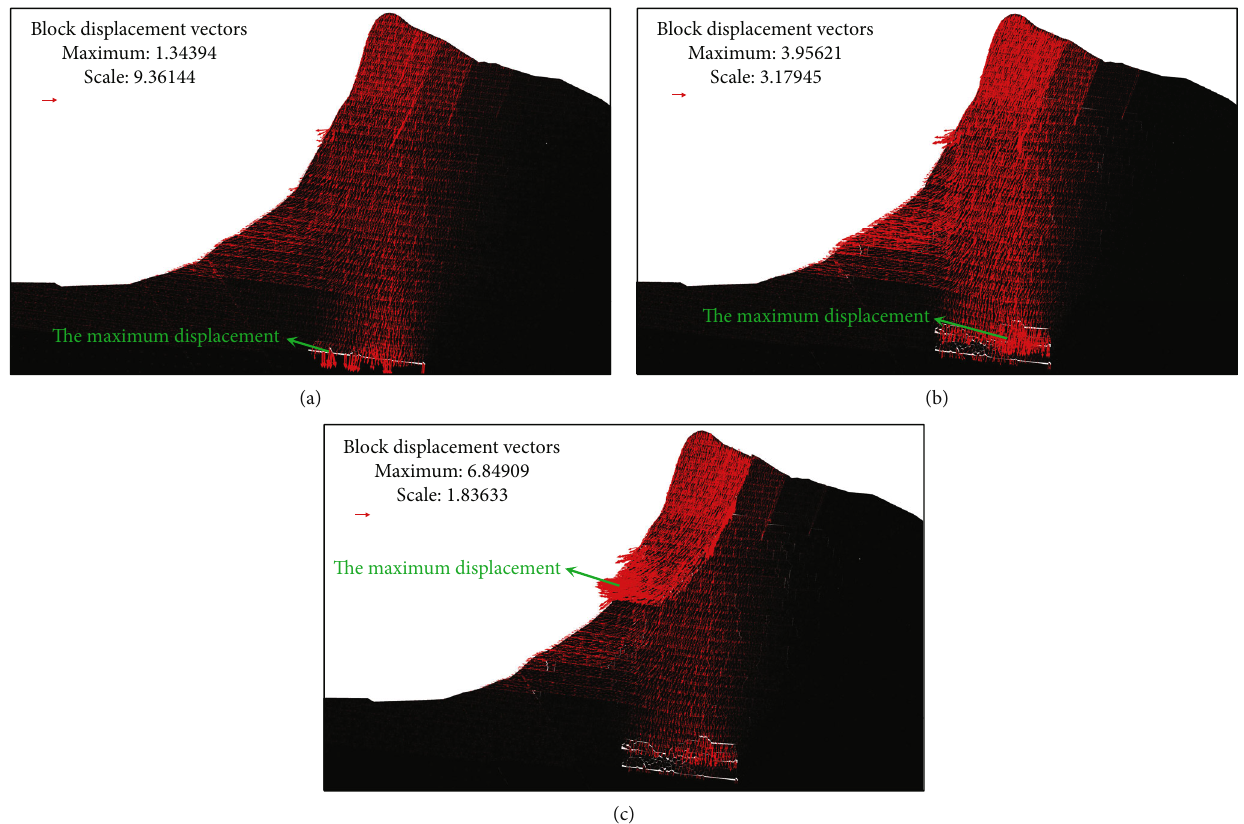
Figure 8: Displacement vector diagram: (a) No. 14 coal seam mined; (b) No. 10 coal seam mined; (c) after heavy rainfall.